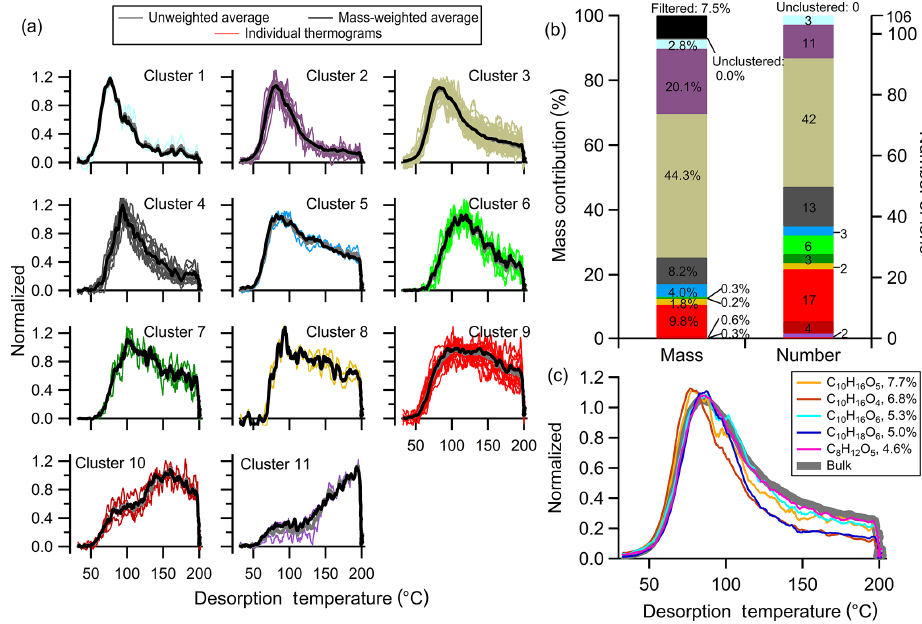
Figure 5. Clustering results for α -pinene + OH SOA. (a) Unweighted average thermograms (bold gray lines), mass-weighted average ther- mograms (bold black lines), and individual members (colored lines) of the 11 clusters identified. (b) Percentage contribution of each cluster to the total mass, the filtered-out and unclustered mass percentage (left bar), the number of ions in each cluster, and the unclustered number of ions (right bar). (c) Thermograms of the top five ions in terms of mass contribution. The cluster colors are consistent between (a) and (b) .